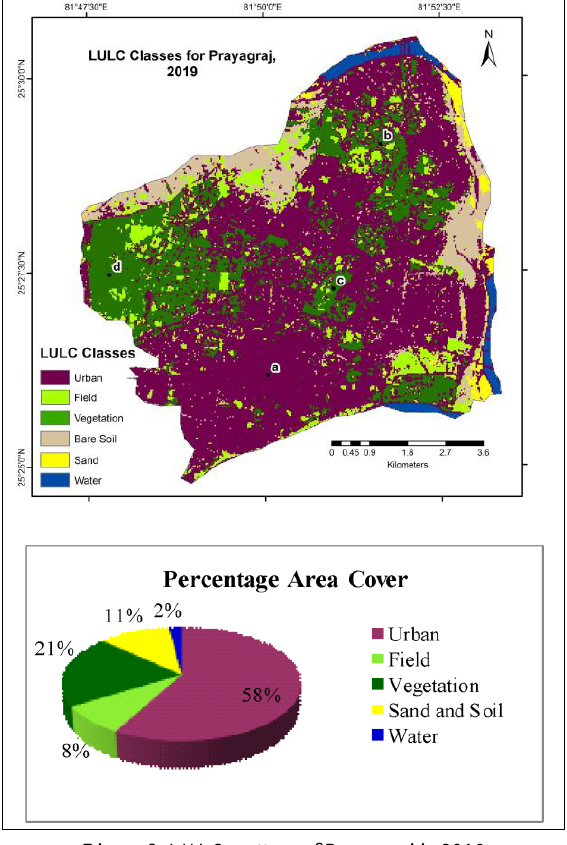
Figure 8. LULC pattern of Prayagraj in 2019 To further understand the effect of land surface characteristics on UHI development, the average temperature of major LULC classes were noted and are listed in Table 1. As the images were captured in morning, heating in open fields, sand and bare soil was rapid. This is clearly depicted by the high average LST of these classes. Between urban and vegetation classes, the difference in average LST was much higher in summer. The urban built up in summer was 1.21 ⁰ C warmer on an average, than green areas. In winter morning, this difference was 0.09 ⁰ C.